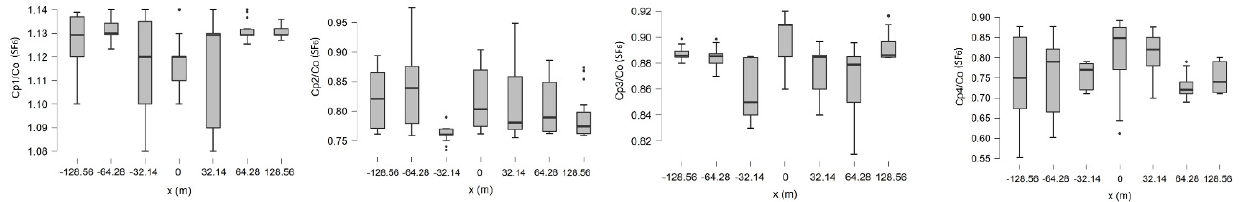
Figure 1. Cp/Co for SF 6 using CALRANS99 data (Data 1) for stable atmospheric conditions concern- ing the downwind distances.